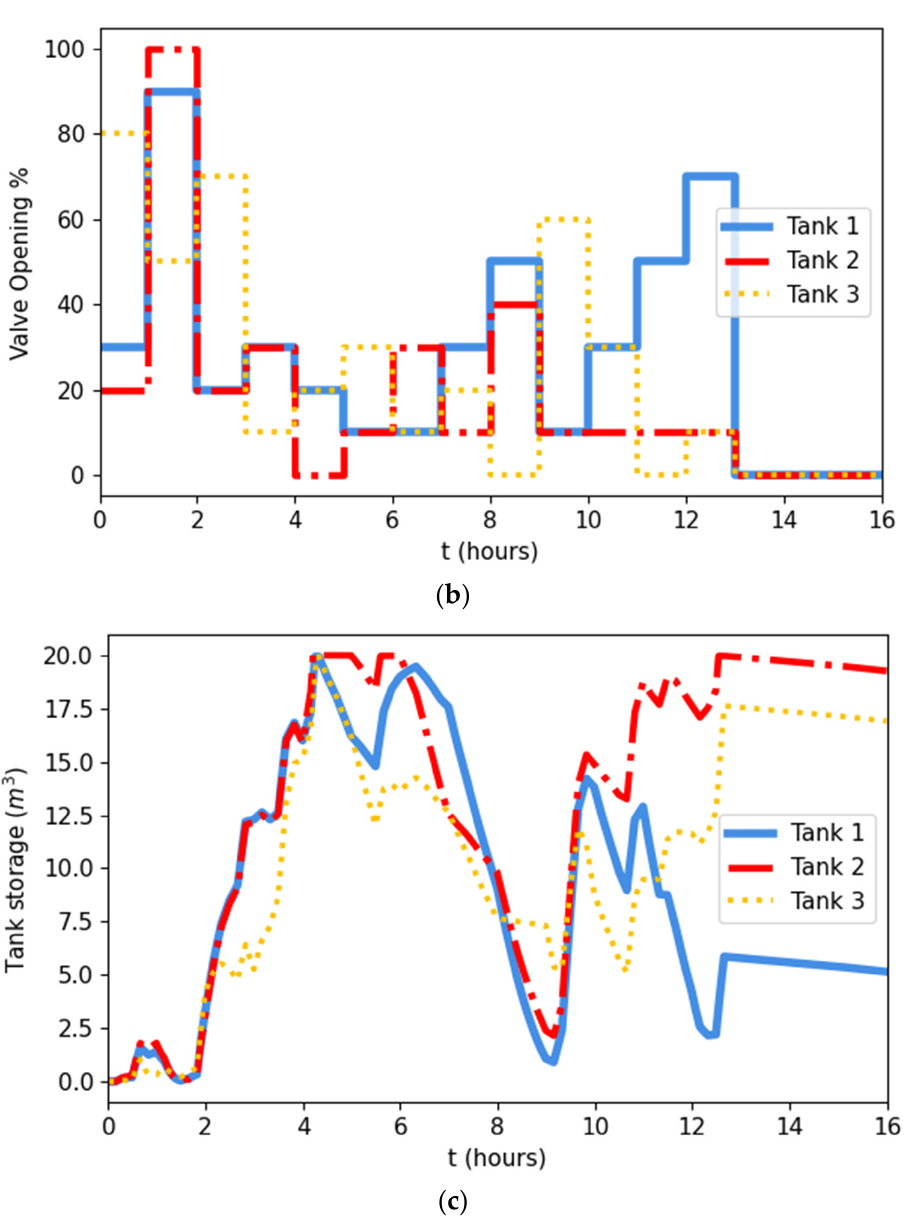
Figure 6. Results of applying the optimization process on a rain event recorded by the Beit Dagan meteorological station on 25–26th February 2010. ( a ) Flow pattern of benchmark run (no controlled releases—red) and from applying the optimized controlled release policy (blue). Q objective , which was used to evaluate the policy’s fitness according to Equation (5), is plotted in dashed green. ( b ) The controlled release policy, which was derived by applying the genetic algorithm—the degree of each valve’s opening during the simulated event. ( c ) Water stored in each tank during the simulated event.